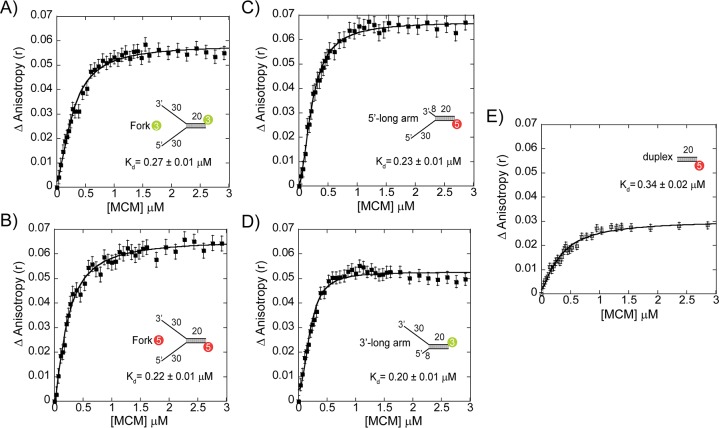
DNA binding by fluorescence anisotropy.DNA binding was determined by fluorescence anisotropy for each of the DNA substrates. The binding constants (Kd) for equal arm fork DNA substrates (5’-Cy3 labelled or 3’-Cy3 labelled), 3’- long arm (5’-Cy3 labelled), 5’- long arm (3’-Cy5 labelled), and duplex DNA (5’-Cy5 labelled) are given in the plots. Error bars represent standard error from three independent experiments and data was fit to Equation 4.